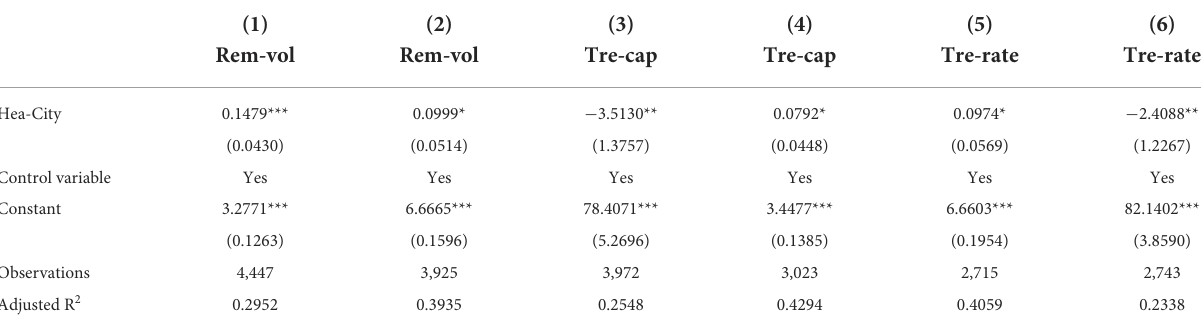
TABLE 3 PSM-DID regression